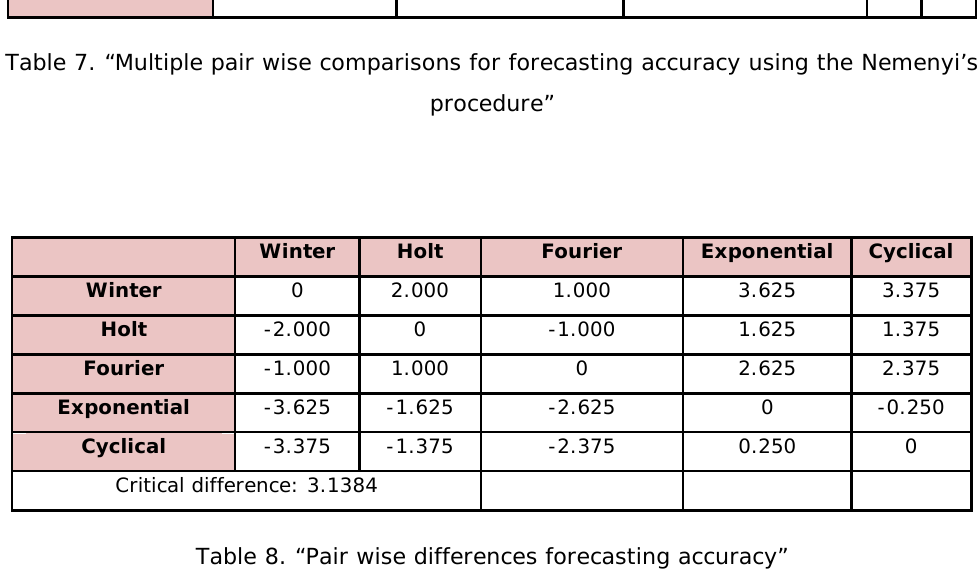
Table 8. “Pair wise differences forecasting accuracy”